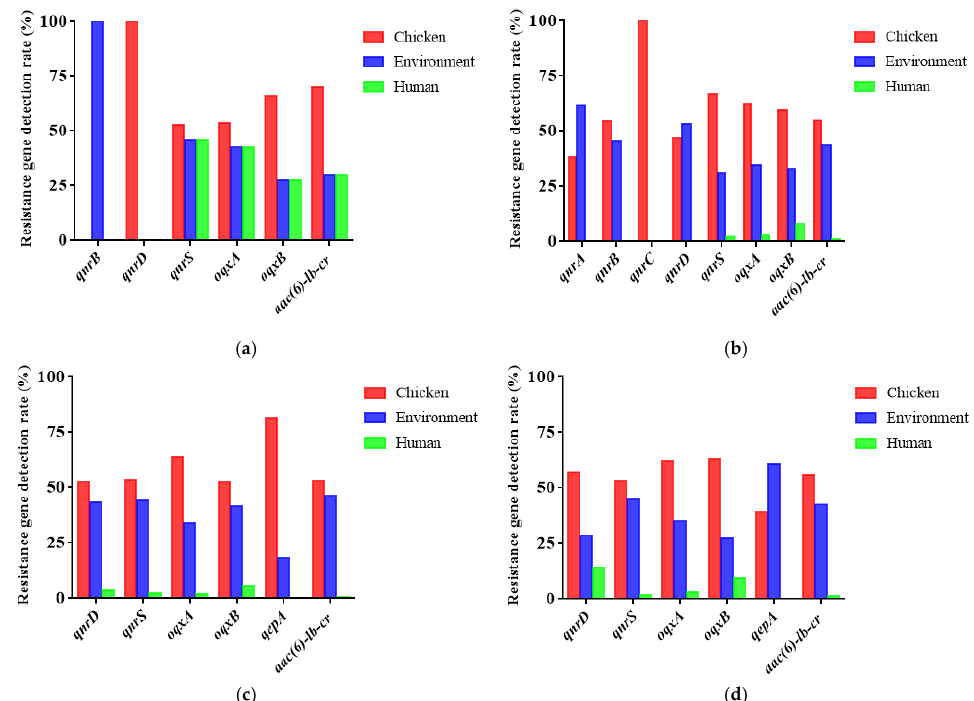
Figure 5. Detection rate of each drug resistance gene in E. coli from different cycles and sources. ( a – d ) respectively represent the first cycle to the fourth cycle.